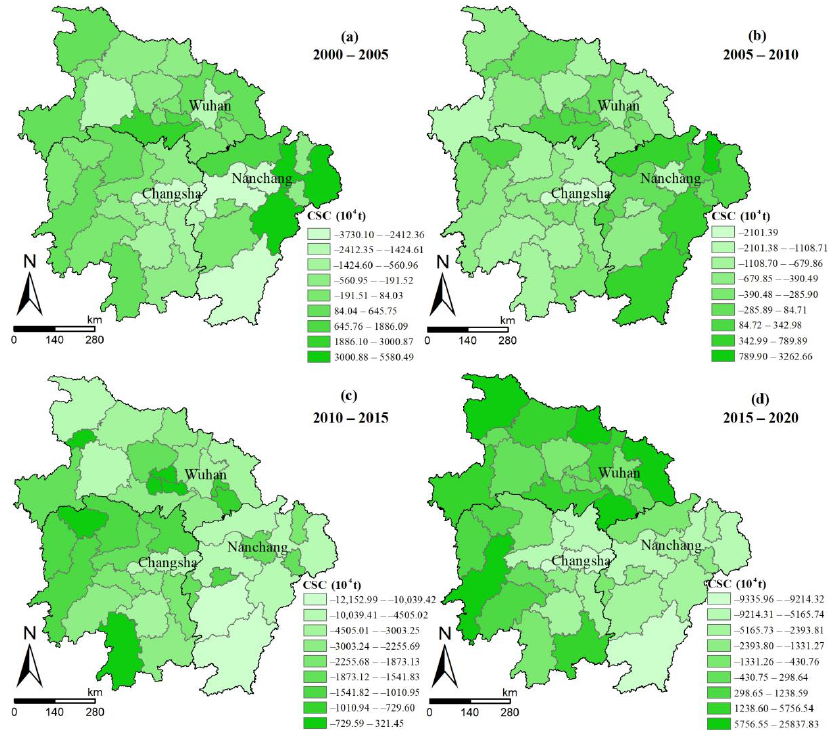
1 Figure 5. Carbon sink changes in the Middle Reaches of the Yangtze River from 2000 to